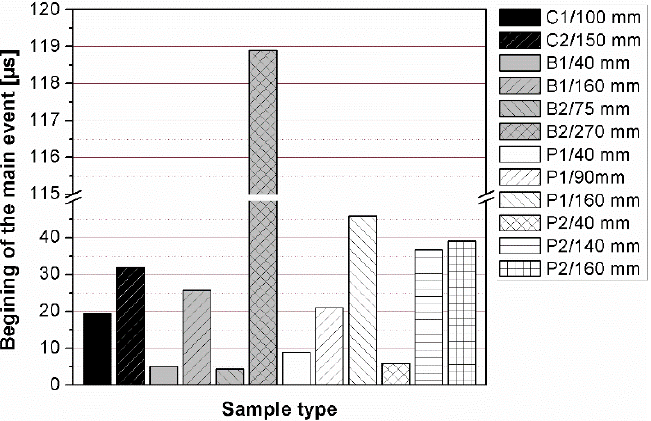
Figure 14. Changes in beginning time of the main event depending on the sample geometry.